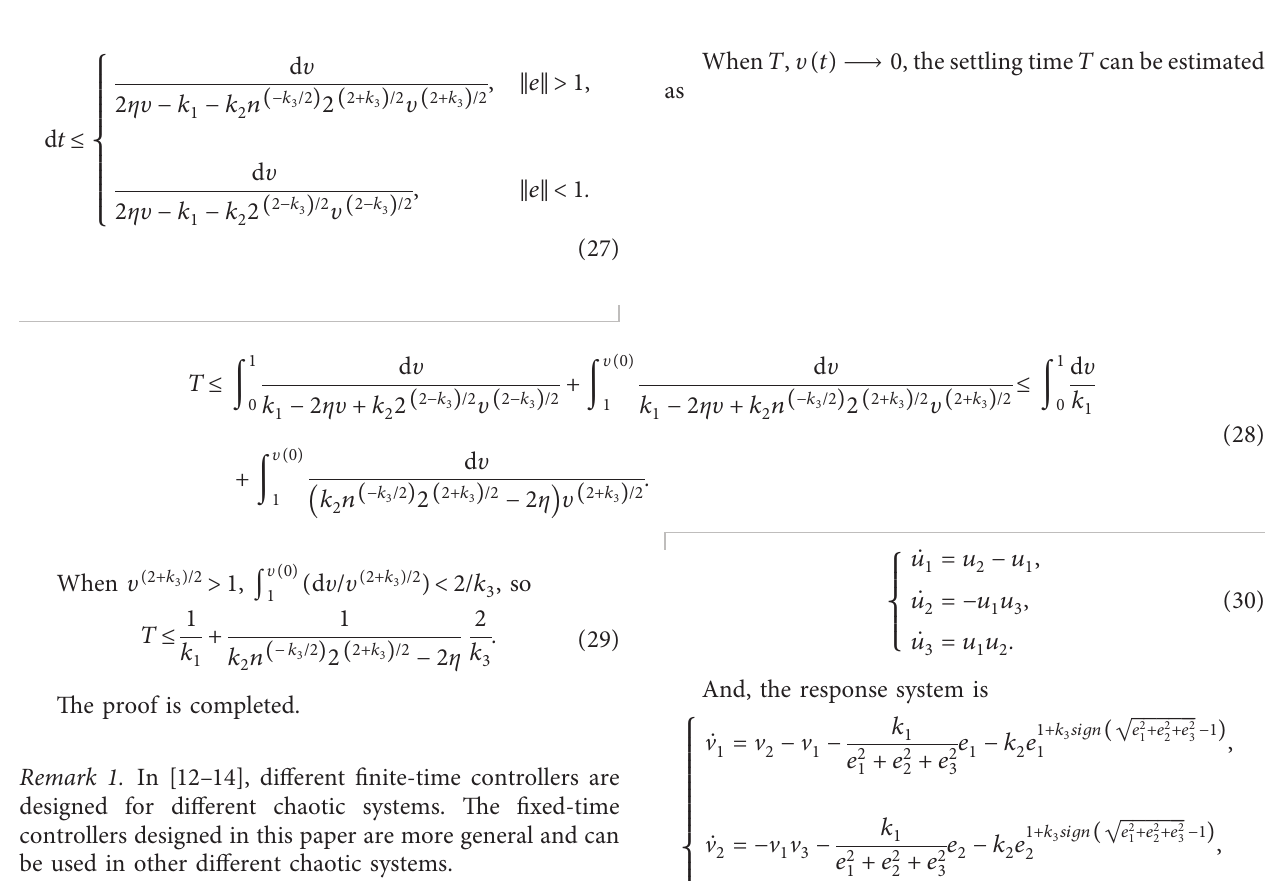
Figure 8: Error evolution without the